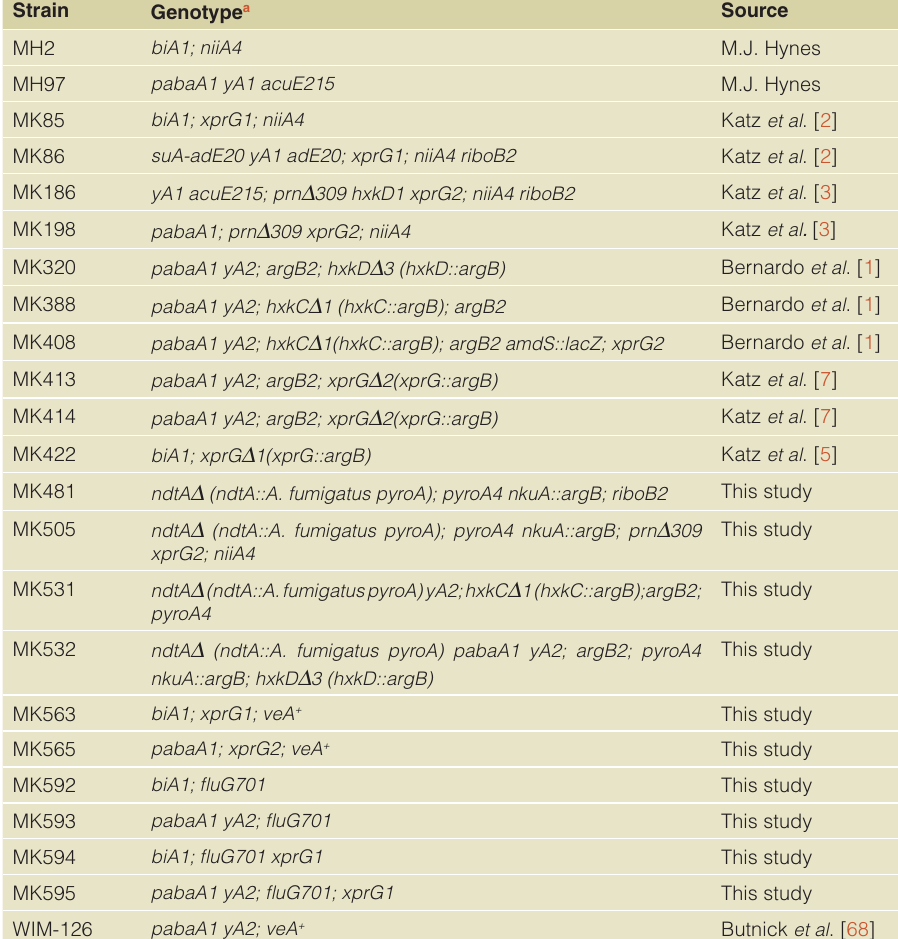
Table 1. List of Aspergillus nidulans strains used in this